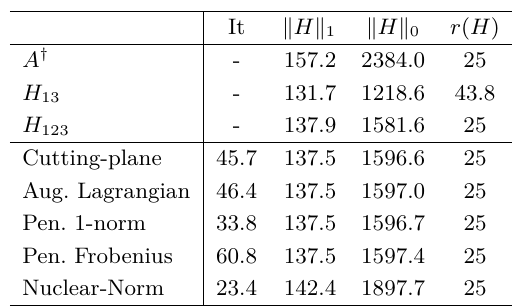
Table 1 Comparison of solutions of the methods proposed with A † , H 13 , and H